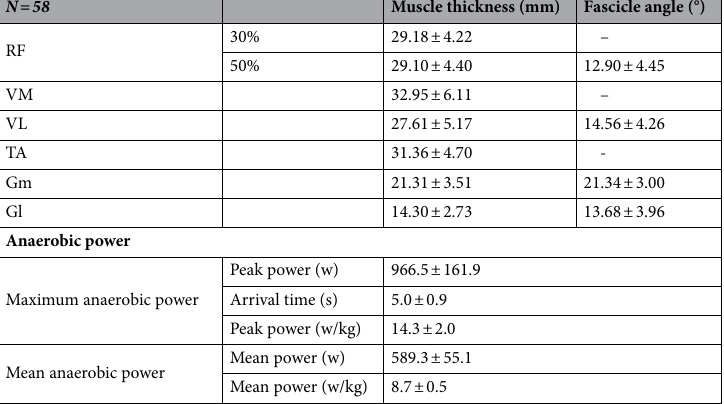
N = 58 Muscle thickness (mm) Fascicle angle